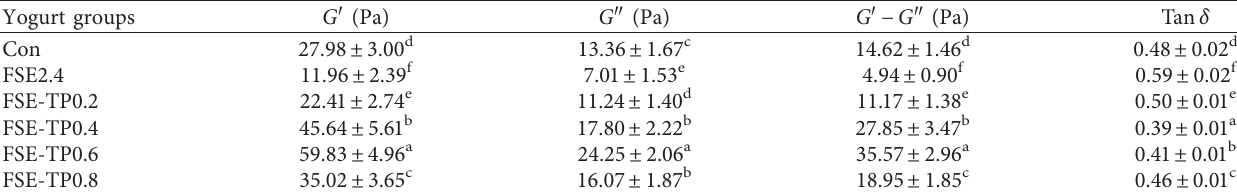
Table 2: The values of G ′ and G ″ , differences between G ′ and G ″ , and tan δ in the linear viscoelastic region. Yogurt groups